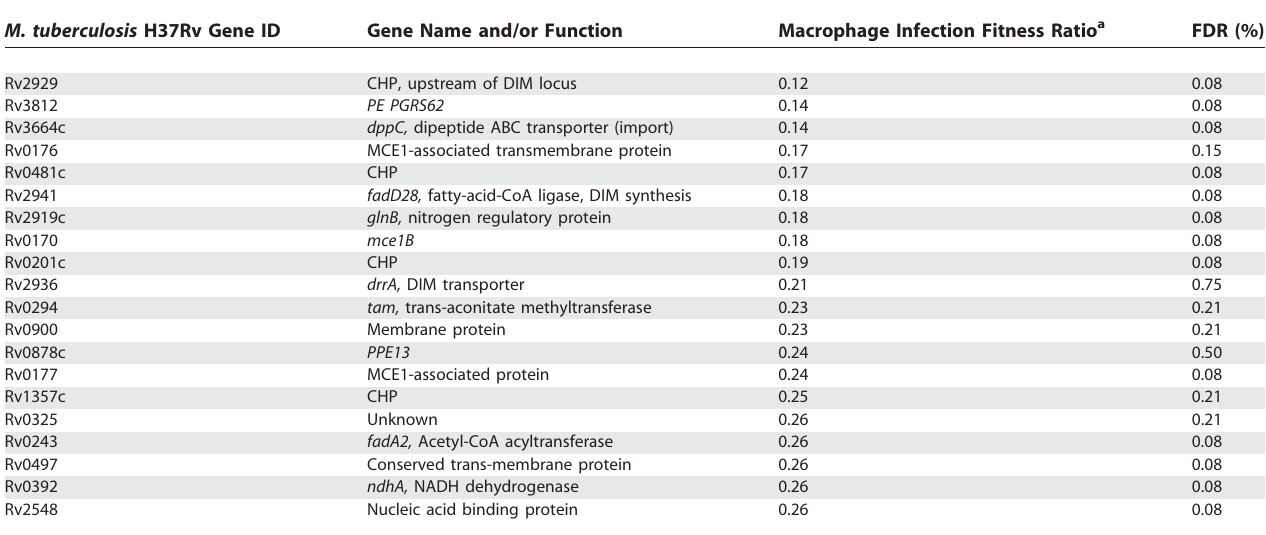
Table 1. Mutants That Incurred the Highest Fitness Cost in Macrophage Culture